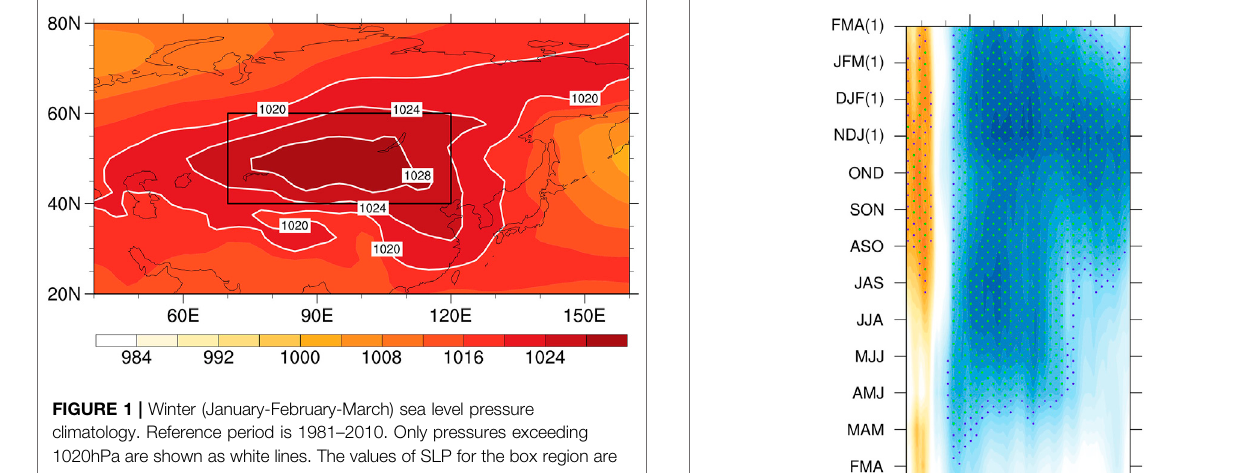
Frontiers in Earth Science |